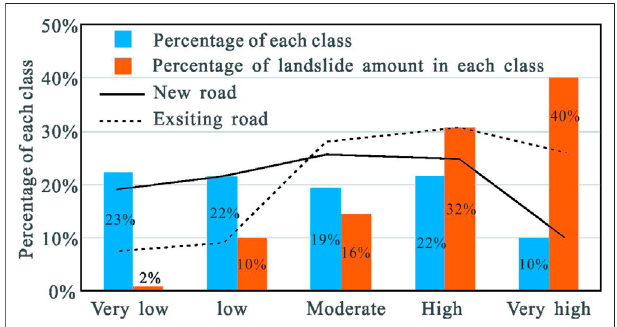
FIGURE 6 | Percentages of landslides and road lengths for each landslide susceptibility